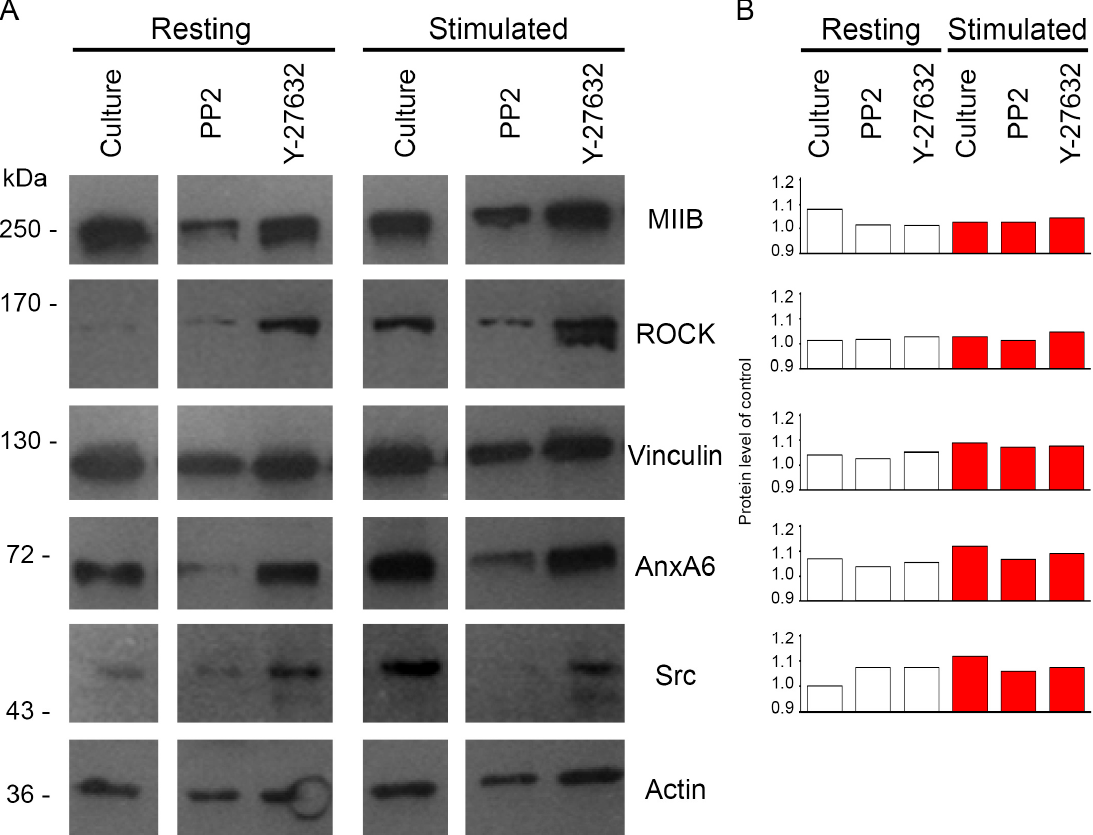
Figure 3. Protein profile in Saos-2 cells, non-treated (Culture) or treated with di ff erent inhibitors: 20 µ M of PP2 or 20 µ M of Y-27632, in resting conditions or after seven-day stimulation with AA and β -GP. Whole cell lysates were prepared in Triton Lysis Bu ff er (TLB). Western blot (WB) ( A ) were incubated with appropriate primary antibodies followed by secondary antibodies conjugated with horseradish peroxidase (HRP). The level of presented proteins was quantified using InGenius software (Syngene) and calculated per actin level and presented as protein level of control ( B ). Data of a typical experiment are presented.